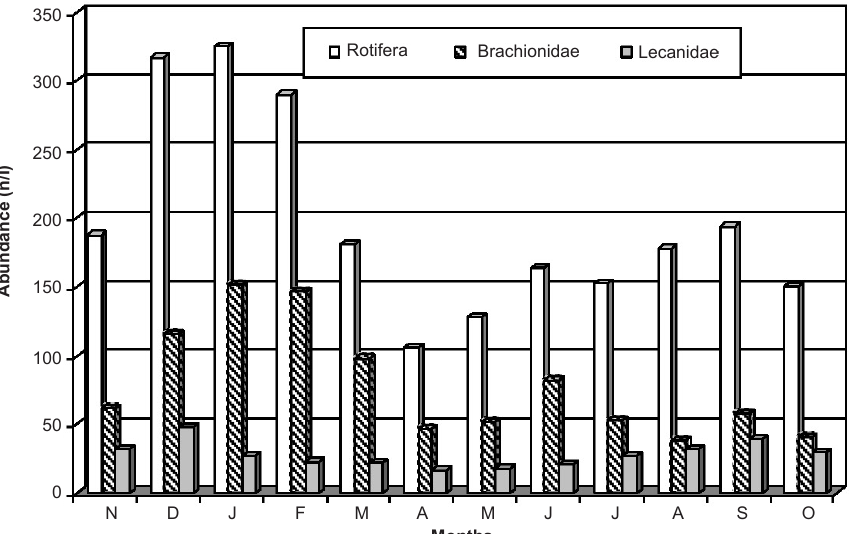
Figure 5. Monthly variations in abundance of Rotifera and important families (Station